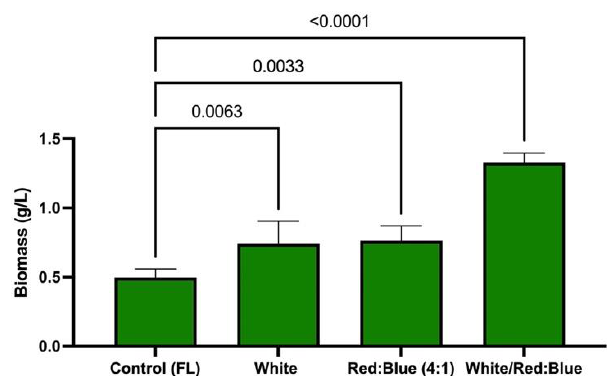
Figure 2. Biomass is produced under different LEDs